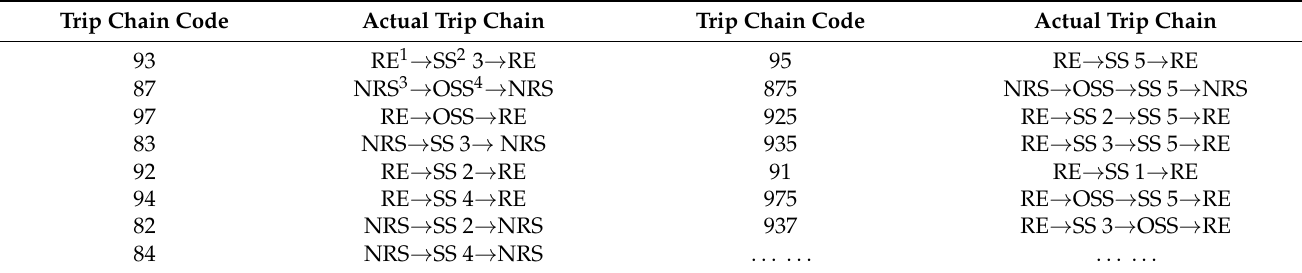
Table 3. Trip chain code and the corresponding actual trip chain.